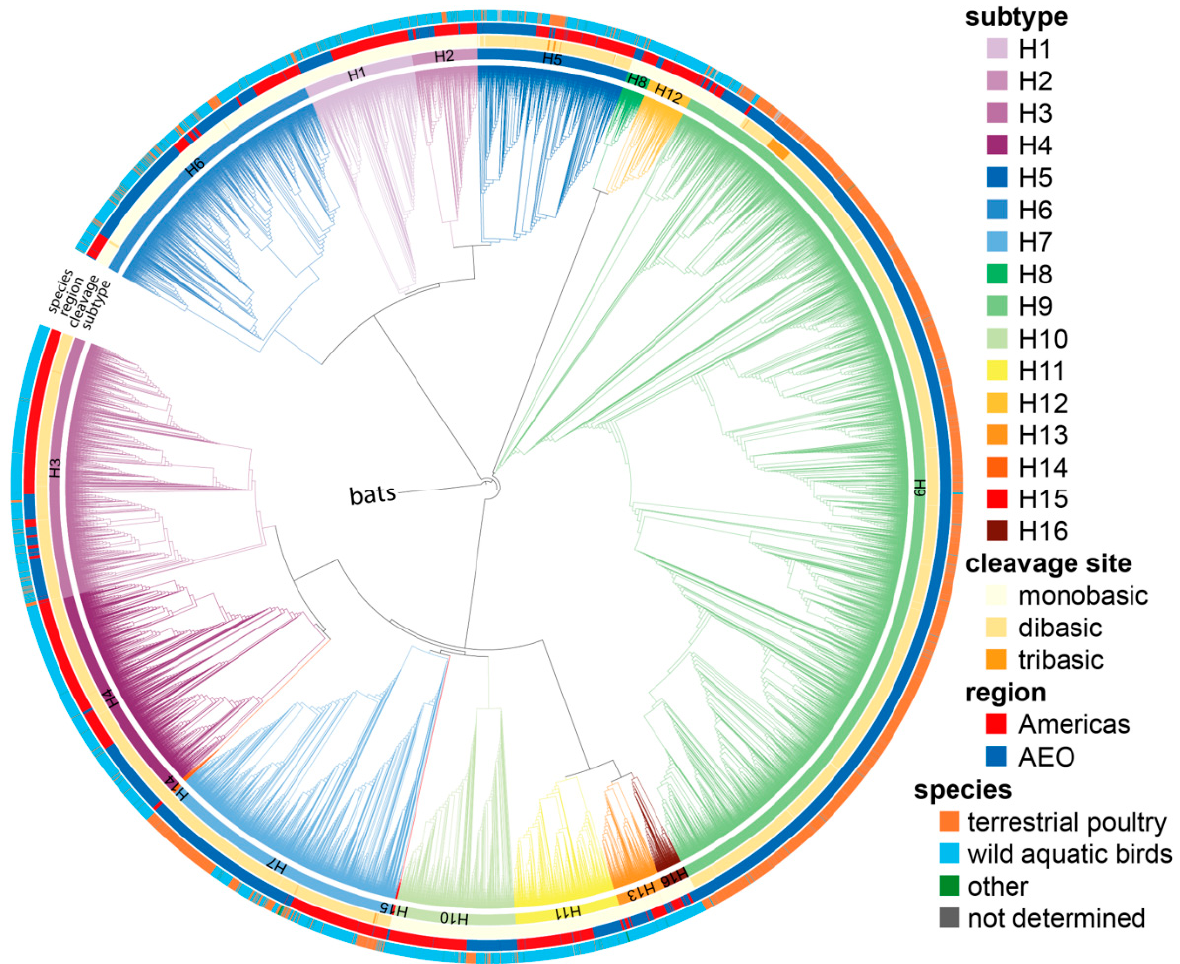
Figure 1. Phylogenetic tree of all 20,448 full-length LPAIV HA nucleotide sequences. The tree was generated after HA subtype reassignment of incorrectly annotated sequences. Branch lengths are arbitrary, and clades are colored by HA subtype using the colors indicated on the right. The clade containing H17 and H18 bat sequences was collapsed and used as root. The inner to outer rings show, respectively: the HA subtype, the number of basic amino acids in the P4 to P1 region (mono-, di-, or tribasic), the region of isolation (Americas or Africa–Eurasia–Oceania, AEO), and the species in which the corresponding virus was isolated (terrestrial poultry, wild aquatic birds, other, and not determined) using the colors indicated on the right.